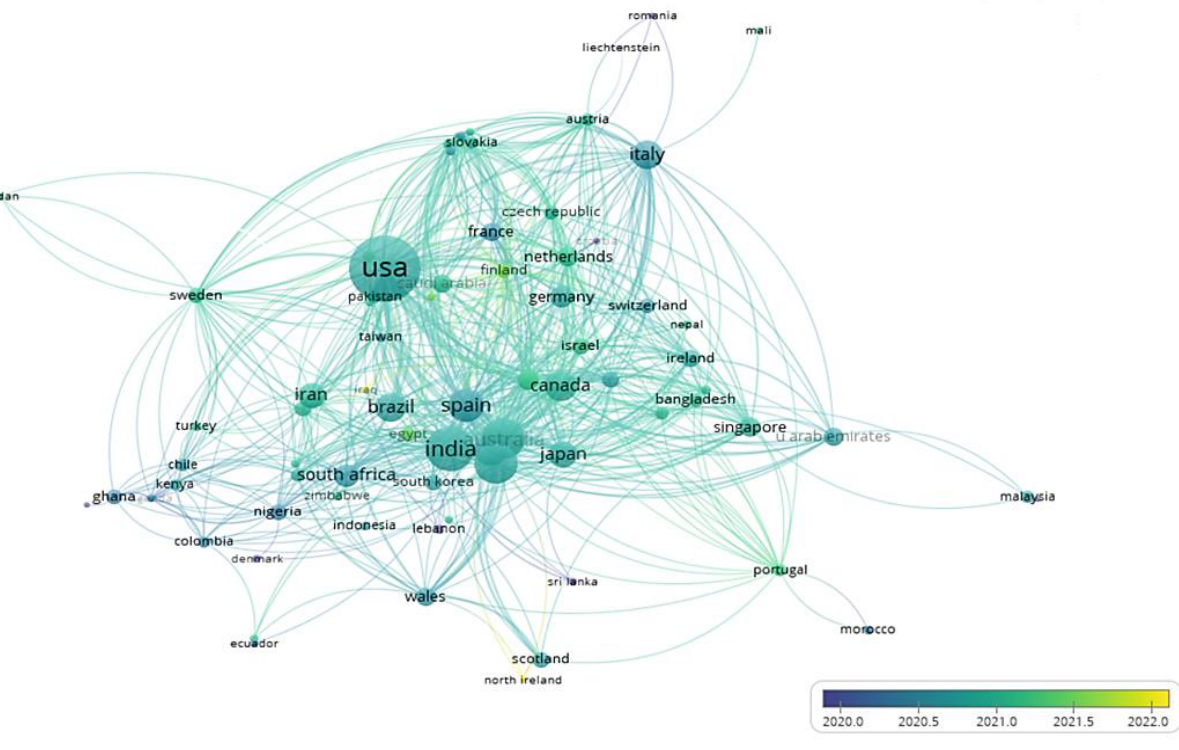
Figure 6. Countries’ coupling/collaboration based on the average number of publications per year in the WoS and Scopus databases.